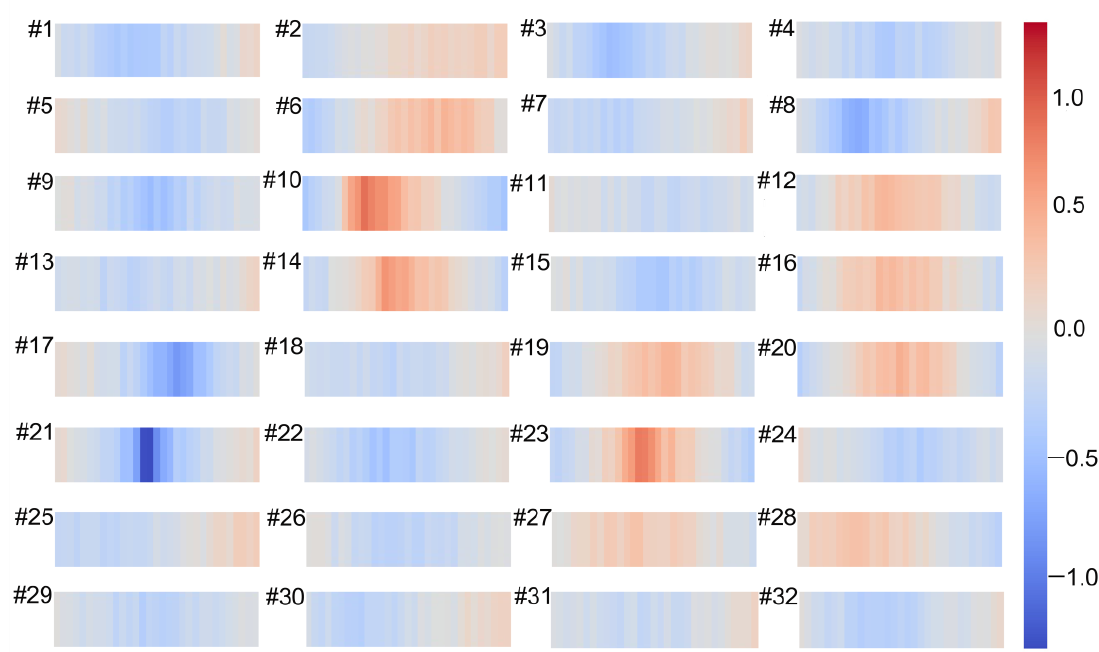
Figure 6. Visualization of 32 filters weights for the first convolutional layer by the one-dimensional convolutional neural network (1DCNN) model for simultaneous prediction of soil properties and vegetation coverage (VC).